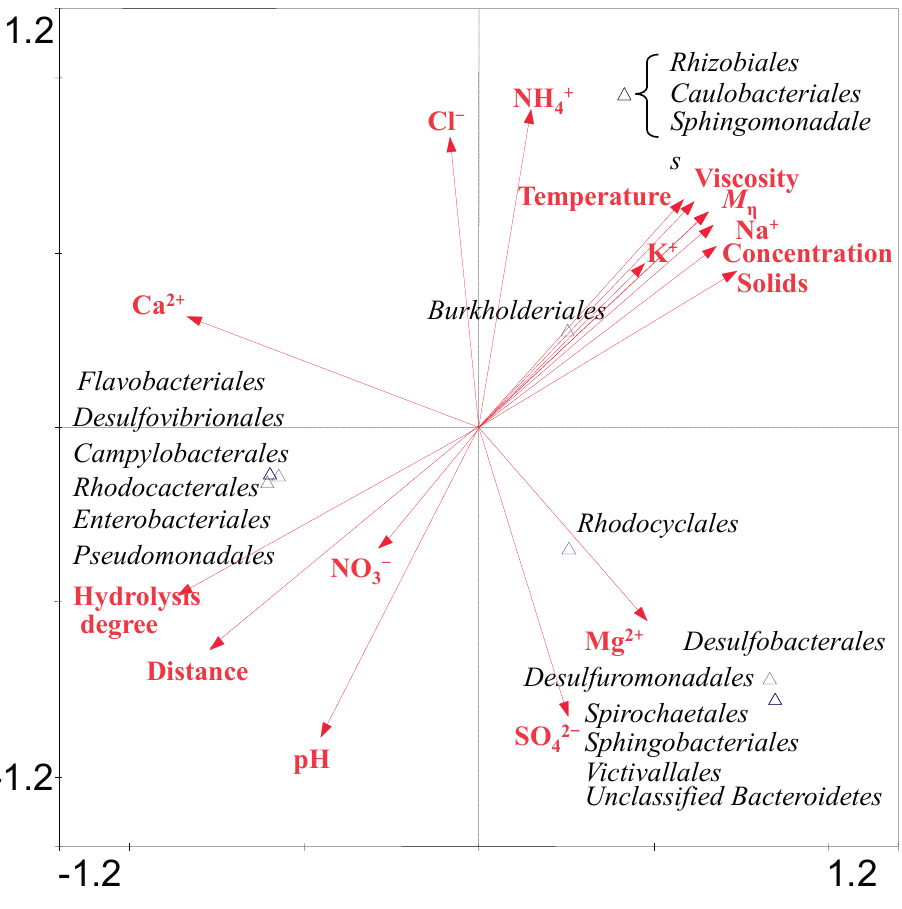
Figure 6. CCA ordination plots for the two dimensions to show the relationship between the bacterial diversity and environmental parameters analyzed using a 16S rRNA gene sequences in the water injection system of four samples. Correlations between environmental variables and CCA axes are represented by the length and angle of arrows (environmental factor vectors). Triangle means one or several species appearing